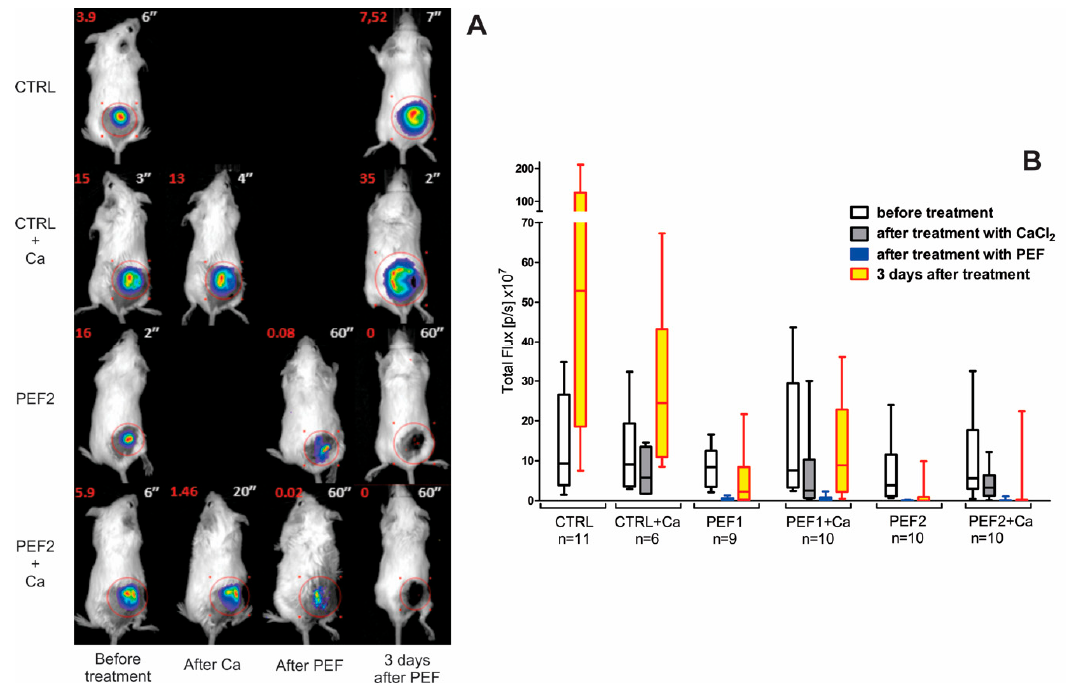
Figure 1. The changes of bioluminescence of the tumors after pulsed electric fields (PEF) and calcium electroporation (PEF + Ca), where ( A ) representative pictures of bioluminescence in vivo ; total fluxes (p/s x 10 7 ) are shown in red on the left upper corner and the exposure times (in seconds) are shown on the right upper corner of every image; ( B ) changes in tumor bioluminescence immediately after the treatment and three days later; CTRL – tumor-bearing mice ; CTRL + Ca – tumor-bearing mice treated with CaCl 2 ; PEF1 - 12 kV/cm × 200 ns × 500; PEF2 - 12 kV/cm × 500 ns × 500.